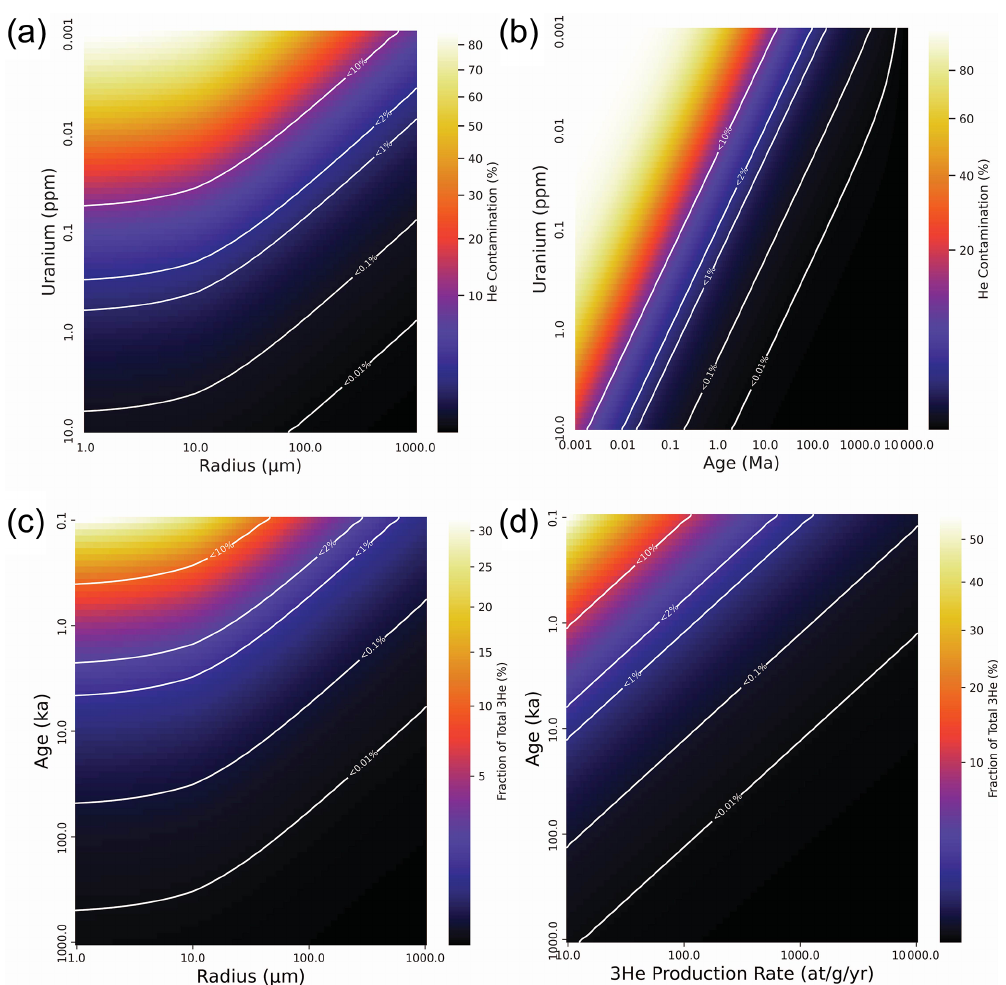
Figure 3. Modeled effects of He contamination on radiogenic (U–Th) / He apatite (a, b) and cosmogenic 3 He olivine (c, d) samples. Panels (a) and (b) show contamination as a fraction of total He (radiogenic and contamination) due to cracking in crystal fragments of a certain size, age, and U concentration. Panel (a) shows contamination as a function of crystal radius and U concentration with a fixed age of 1Ma. Panel (b) shows contamination as a function of age and U concentration with a fixed radius of 31.5µm (reflecting a 63µm sieve size). Panels (c) and (d) show the fraction of total cosmogenic He represented by the correction that would be applied to a cosmogenic 3 He measurement if the contamination 4 He is erroneously assumed to be magmatic 4 He with a ratio of 8 R a (following Blard, 2021). The degree to which this correction is incorrect will be a function of the actual difference between the 3 He / 4 He ratio of the contamination He and the assumed or measured magmatic He. Panel (c) shows the fraction of total 3 He as a function of crystal radius and age assuming a fixed 3 He production rate of 125atg − 1 yr − 1 . Panel (d) shows the fraction of total 3 He as a function of production rate and age assuming a fixed crystal radius of 50µm (representing a minimum recommended cosmogenic sample size of 100µm, following Blard, 2021). The spherical model used here is adequate as an approximation for most crystals, but the model code can be modified to account for extreme geometries. Only very young or low-U radiogenic samples and very young or low- 3 He cosmogenic samples will exhibit a problematic degree of He contamination compared to radiogenic He